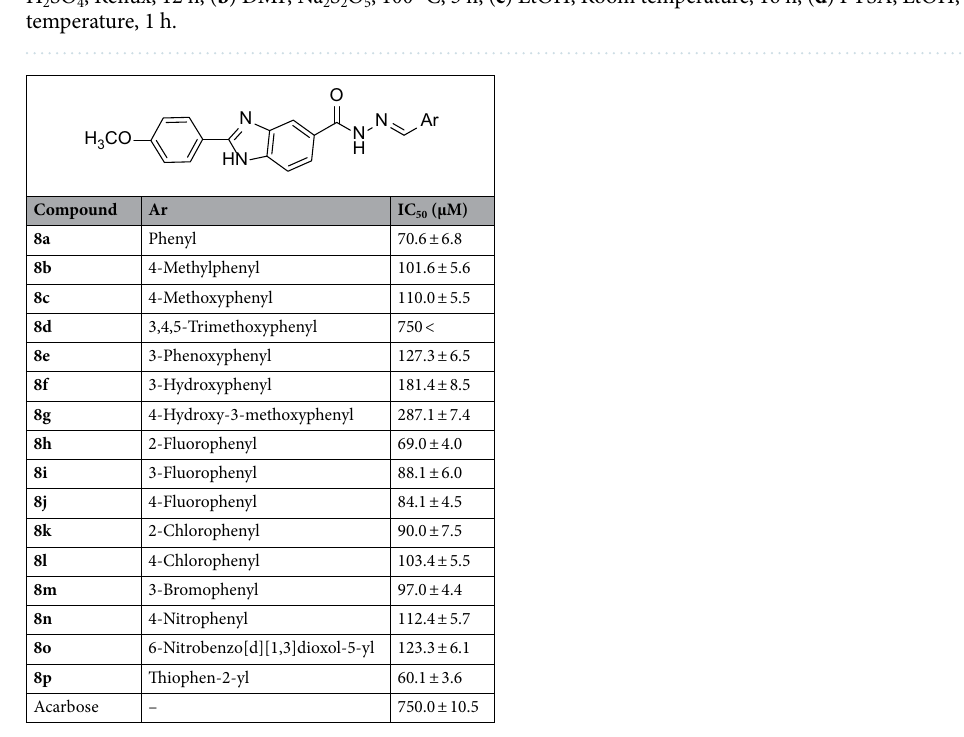
Scheme 1. Reagents and conditions for the synthesis of benzimidazole-Schiff base derivatives 8a–p ; ( a ) EtOH, H